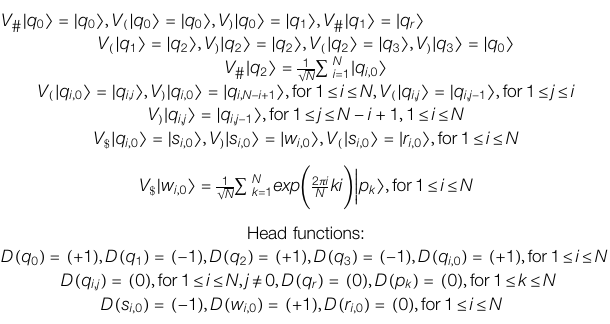
TABLE 2 | Details of the transition functions and head function for L 2 .